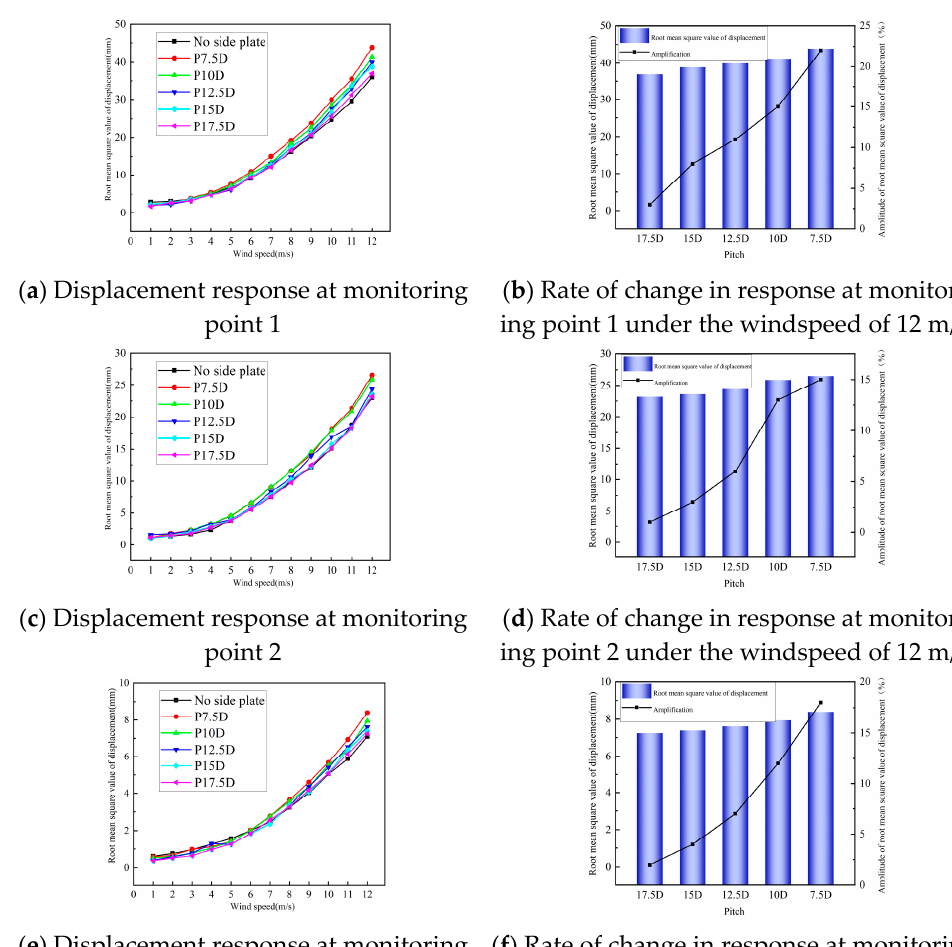
Figure 19. Root mean square value of the along-wind displacement response at the monitoring points of the high light pole structure under different pitch